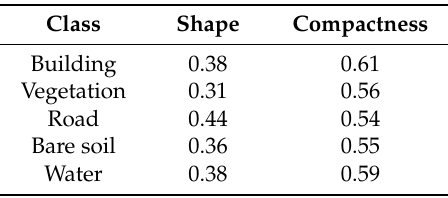
Table 4. Calculated mean values of the shape and compactness parameters used in the reviewed scientific